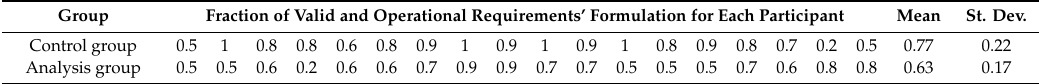
Table 9. Fraction of valid and operational requirements.